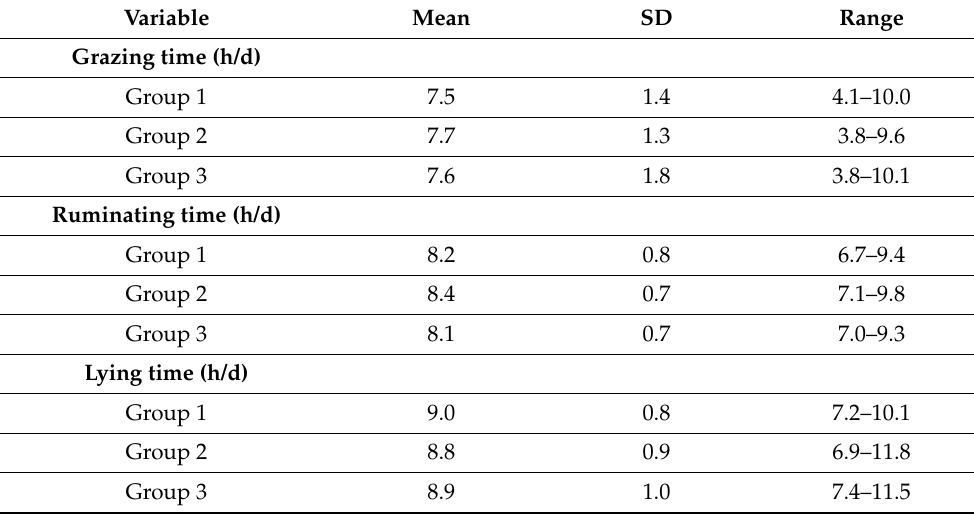
Table 1. Daily behavioural patterns (mean, SD and range (minimum and maximum)) for each of the three groups (29 cows each) managed on a single farm over the experimental period of 13 d. Grazing, ruminating and lying times were measured using accelerometers attached to each cow (data from 29 cows/group). There were no differences in the duration ( p > 0.1) between the groups for any of the